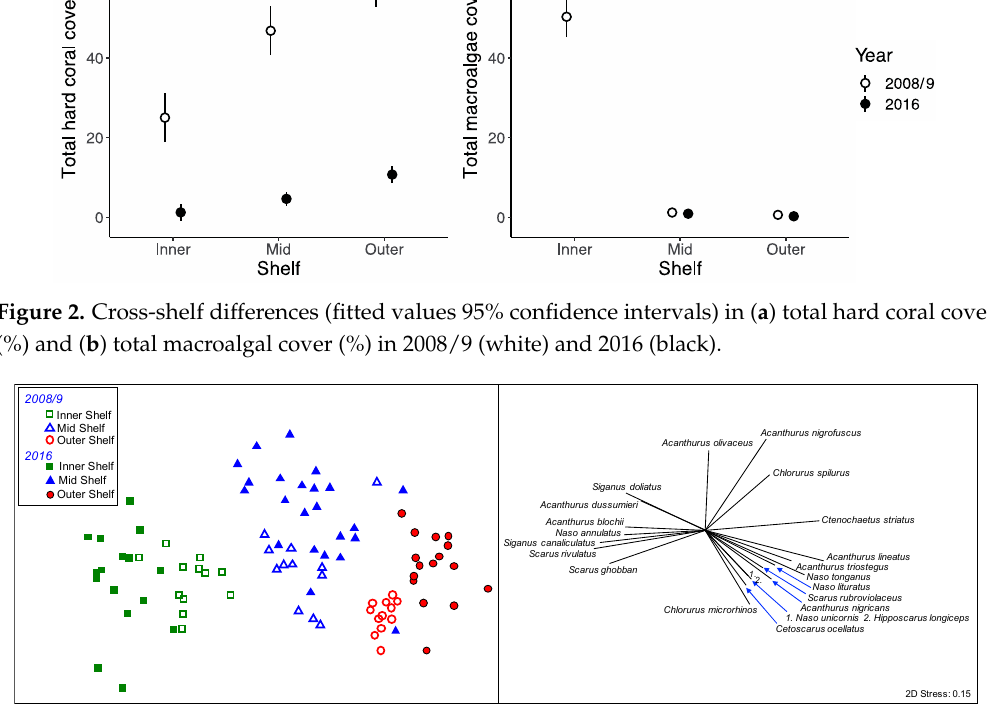
Figure 3. Non-metric multidimensional scaling analysis showing cross-shelf differences in assemblage structure of herbivorous reef fish (green square: inner-shelf; blue triangle: mid-shelf; red circle: outer-shelf) in 2008/9 (open) and 2016 (filled), using transect-level fourth root transformed data. The relative contributions of species to the observed variation in composition are illustrated (>0.4 Pearson correlation).